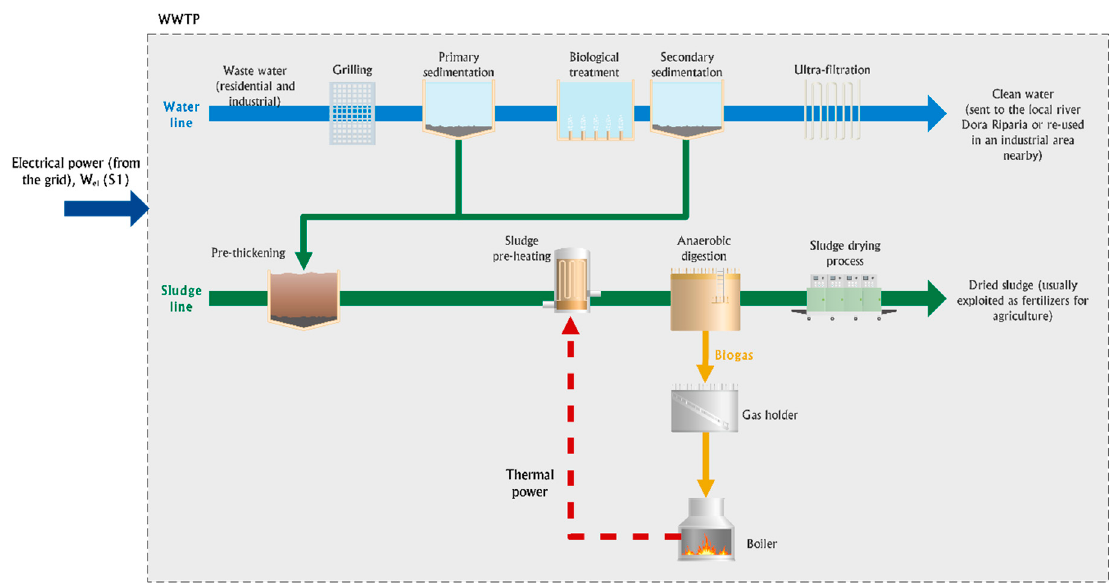
Figure 2. Scenario 1 (Reference scenario): biogas and sludge lines in the WWTP.